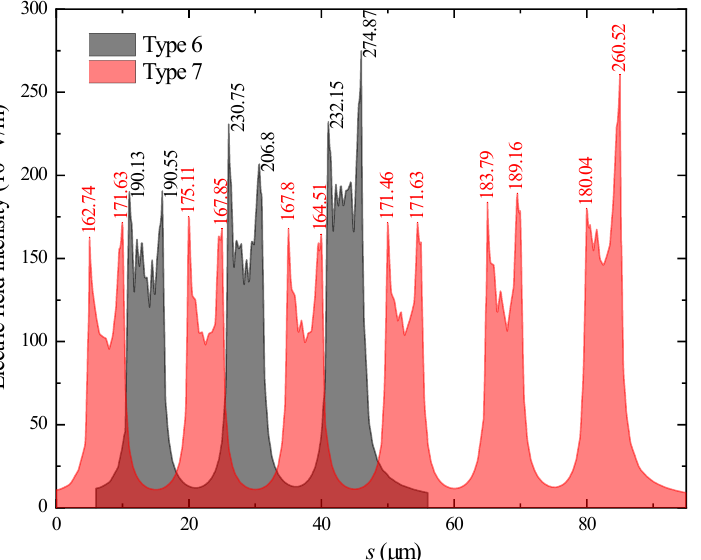
Figure 5. Distribution of the electric field around the fingers on the electrodes with 6 and 12 tips.